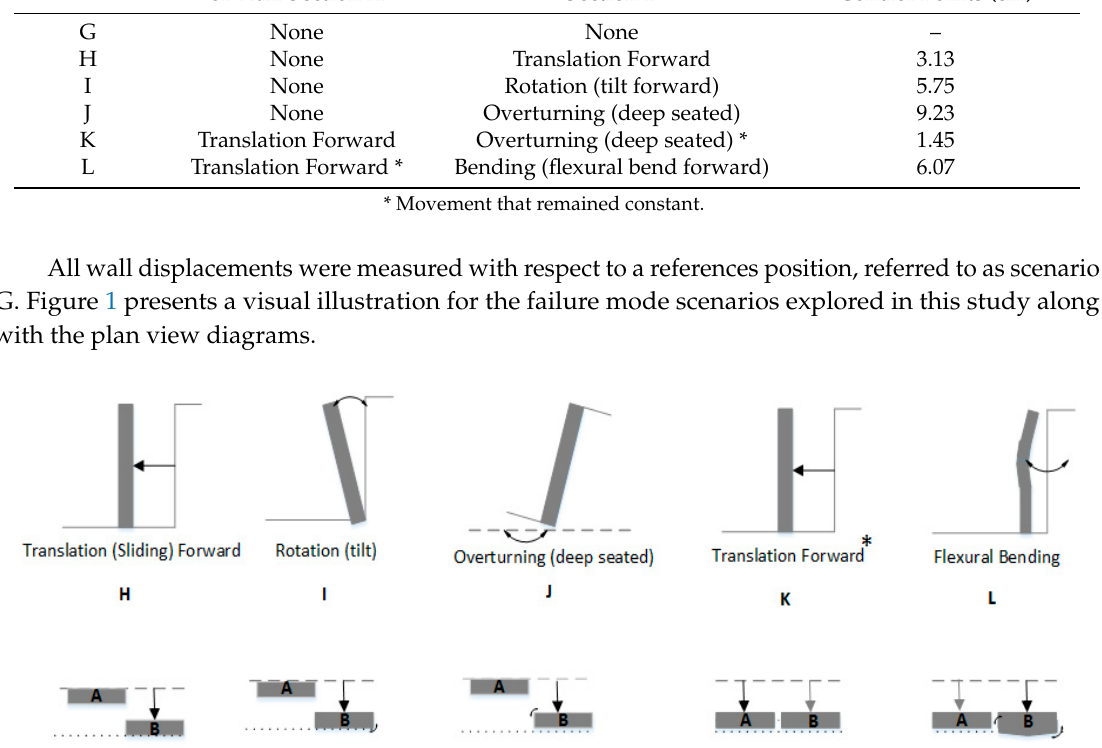
Table 1. Testing scenarios for retaining wall failure observations.